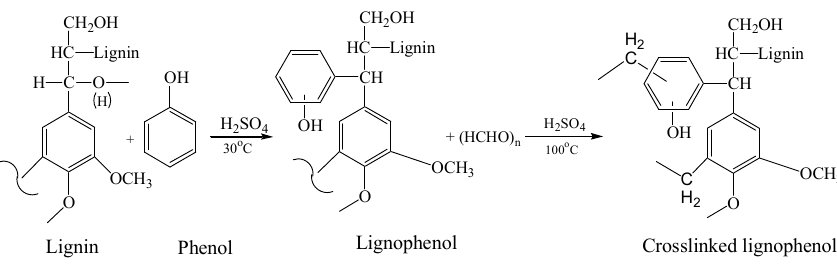
Scheme 2. Synthesis and crosslinking of lignophenol.